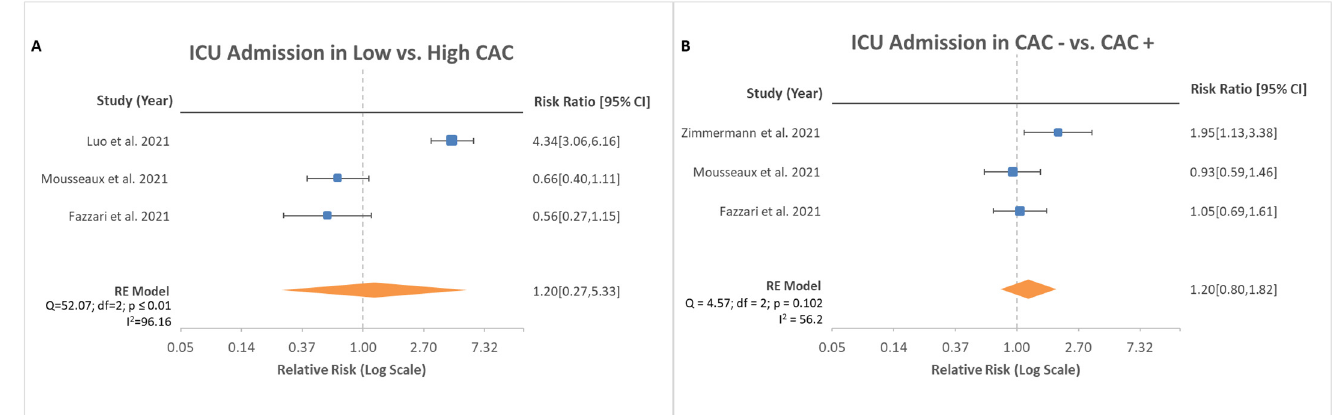
Figure 4. Risk ratio of ICU admission based on stratification of CAC scores. ( A ) depicts risk in low CAC vs. high CAC with total of three studies analyzed with 95% confidence interval. Test for overall effect: Z = 0.23, p = 0.82. ( B ) depicts risk in absence of CAC vs. the presence of CAC with total of three studies analyzed with 95% confidence interval. Test for overall effect: Z = 0.88, p = 0.38.